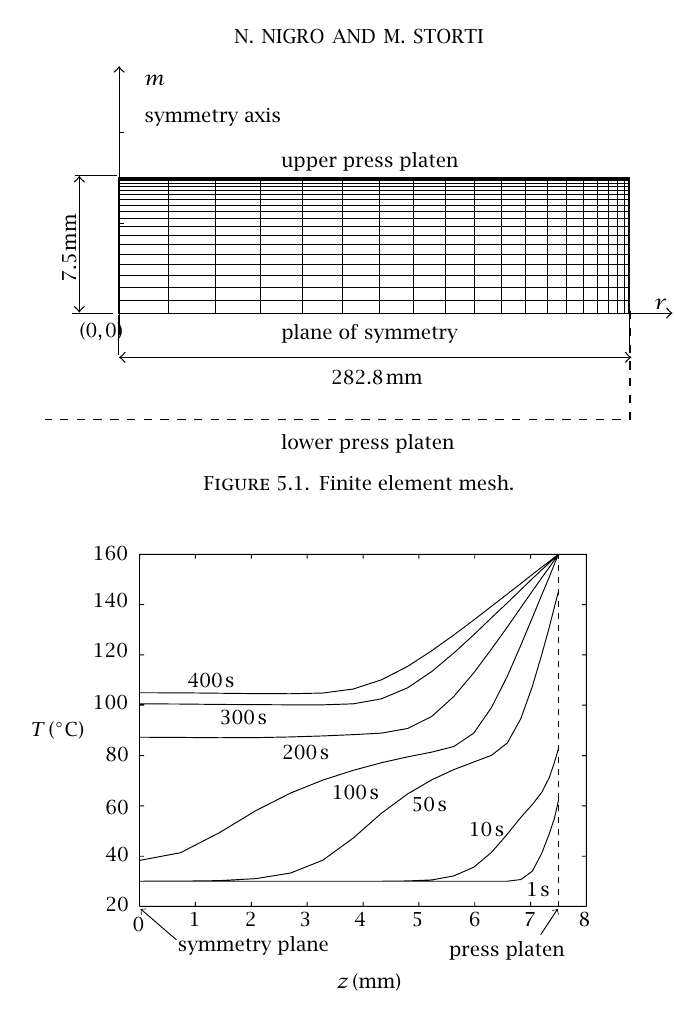
Figure 5.2 . Axial temperature profile at r =